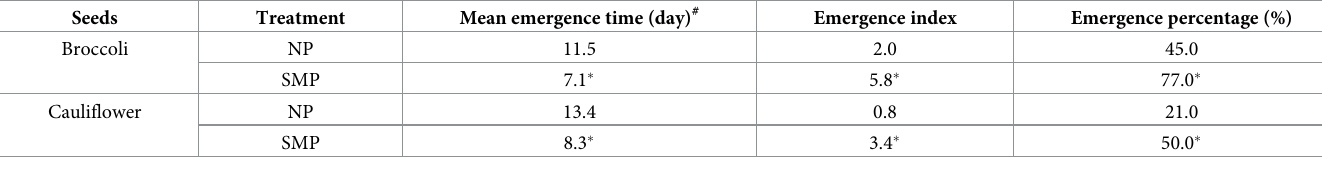
Table 1. Effects of SMP on cauliflower and broccoli seed emergence.